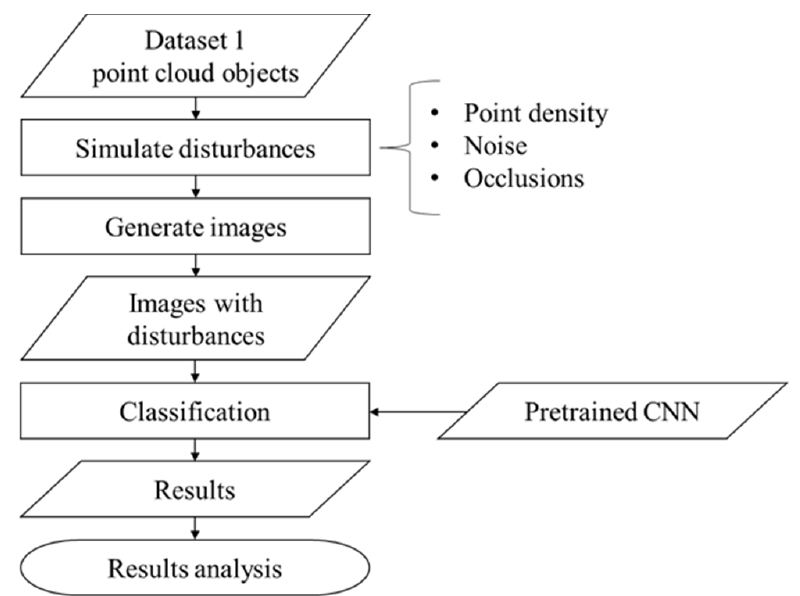
Figure 1. Workflow of the experiment.